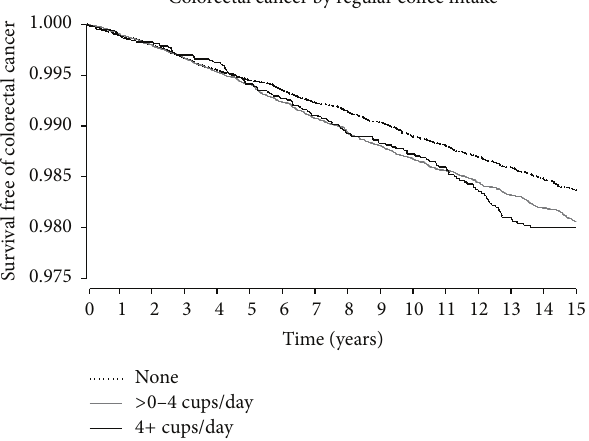
Figure 1: Colorectal cancer survival by coffee intake.